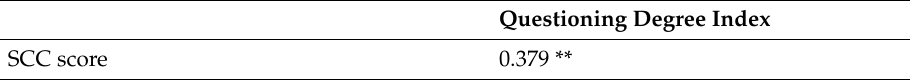
Table 2. Questioning degree index—-SCC score